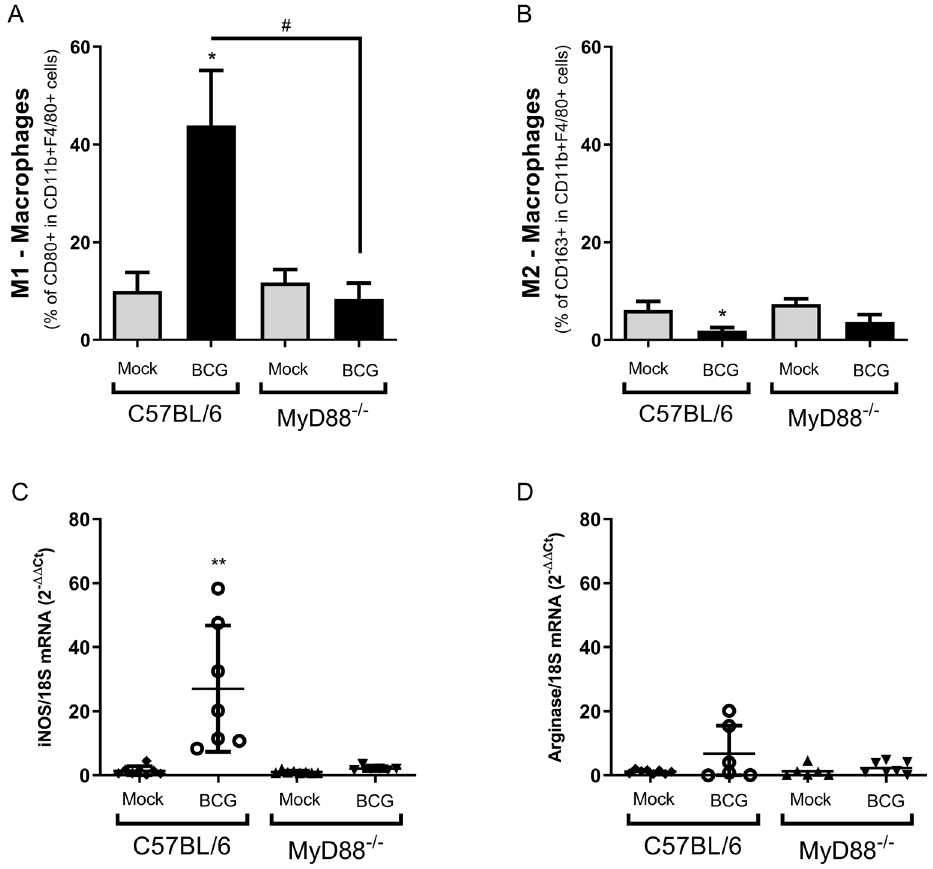
Figure 8. The inflammatory macrophages profile present in TME from tumors treated with BCG. Fifteen days syngeneic tumors from C57BL/6 WT or MyD88 −/− mice (same as used in Fig. 7) were evaluated concerning activation status of macrophages. Cell infiltrate was analyzed by flow cytometry using specific markers to address M1 (CD11b + F4/80 + CD80 +) ( A ) and M2 (CD11b + F4/80 + CD163 +) ( B ) macrophages profiles. The graphs percentages are relative to CD11b + F4/80+ (Macrophages) entire population. The mRNA expression in the same group of tumors was also analyzed by qPCR for the following targets: iNOS ( C ) and Arginase ( D ). All qPCR results were relative to 18S mRNA as normalizer. Untreated (mock) tumors from each group were used as control. Data represents ΔΔCT mean and standard deviation from tumors in two independent experiments. *Statistically significant compared to the respective untreated control (mock), * P < 0.05, *** P ≤ 0.001. # Statistically significant comparing BCG treated C57BL/6 WT and MyD88 −/− , # ## P ≤